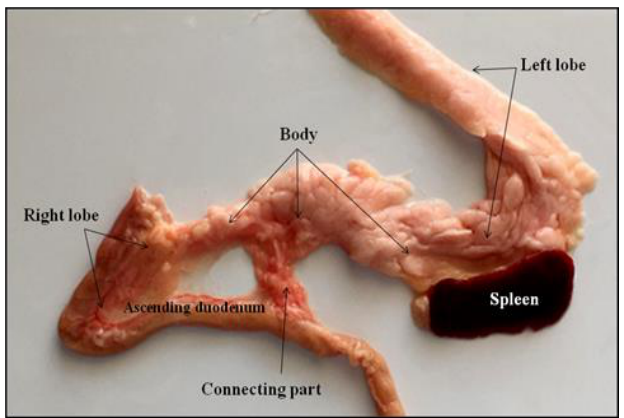
Figure 4. Dissected pancreatic lobes showed gross lobulation of pancreatic lobes.